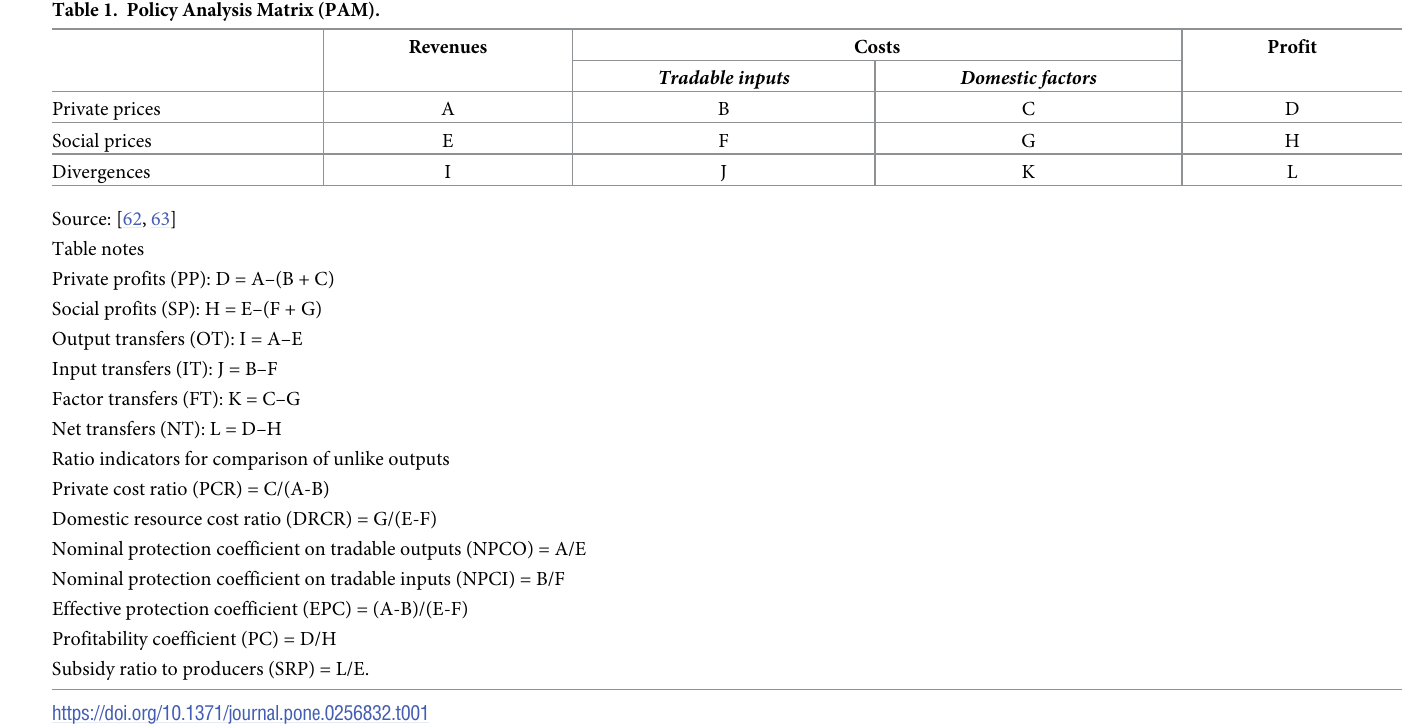
financial or private profits, and the profits in the dry season were larger than those in the rainy season. The financial profit (PP) of shallot farming was highest in Malang district in the rainy sea- son (IDR 60,561,153/ha/season). Simultaneously, the lowest was found in Majalengka district in the rainy season (IDR 10,939,865/ha/season). The largest economic (SP) profit of shallot farming was found in Enrekang district in the dry season with a profit of IDR 186,838,618/ha/